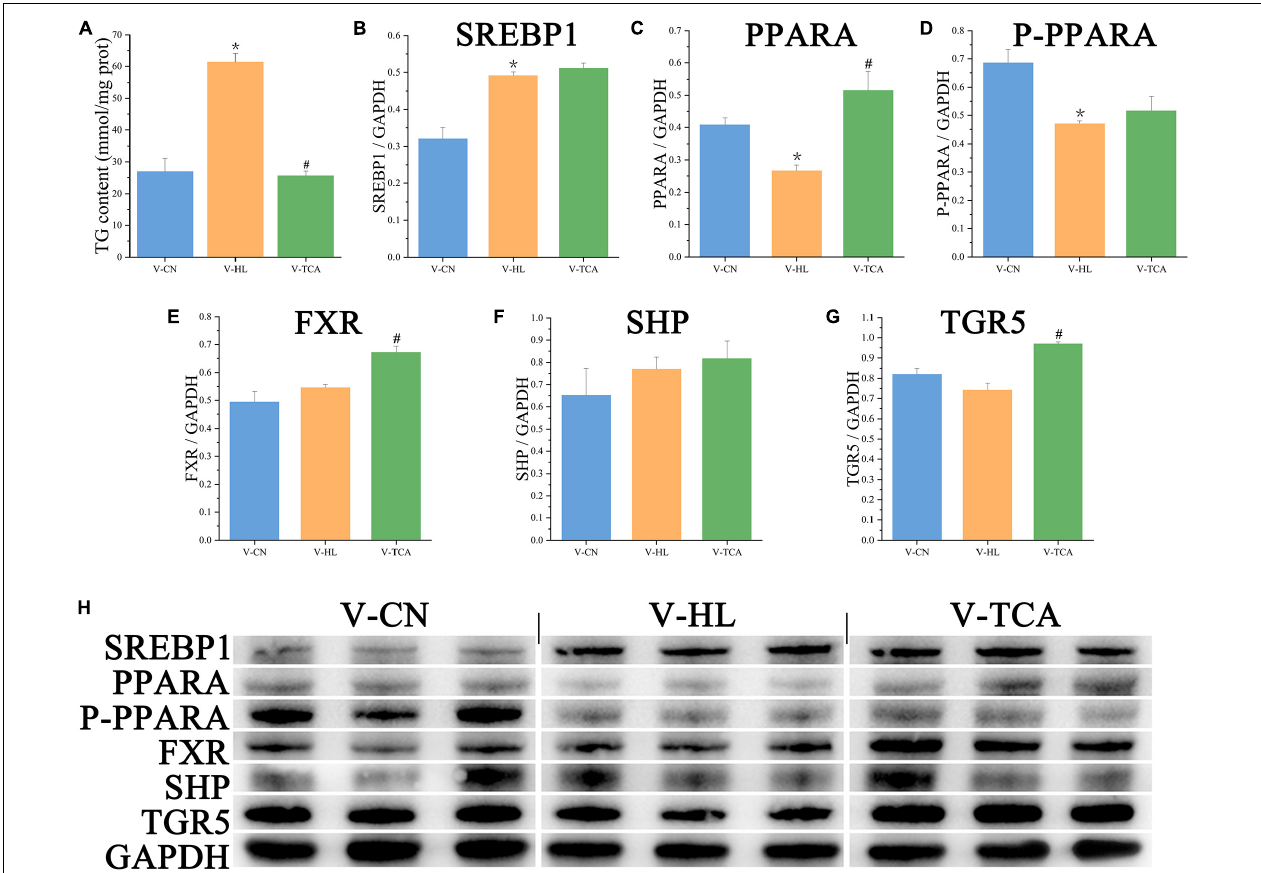
FIGURE 3 | The lipid accumulation and metabolism of hepatocytes in lipid emulsion and BAs incubation. (A) The content of intracellular TG ( n = 9). (B–G) The relative quantification of protein levels of SREBP1, PPARA, P-PPARA, FXR, SHP, and TGR5 normalized to GAPDH in hepatocytes ( n = 3); (H) the Western blot band of hepatocyte samples ( n = 3). Values are presented as means with SD , where “*” indicates significant ( p < 0.05) differences in the V-HL group (compared to the V-CN group), and “#” indicates significant ( p < 0.05) differences in the V-TCA group (compared to the V-HL